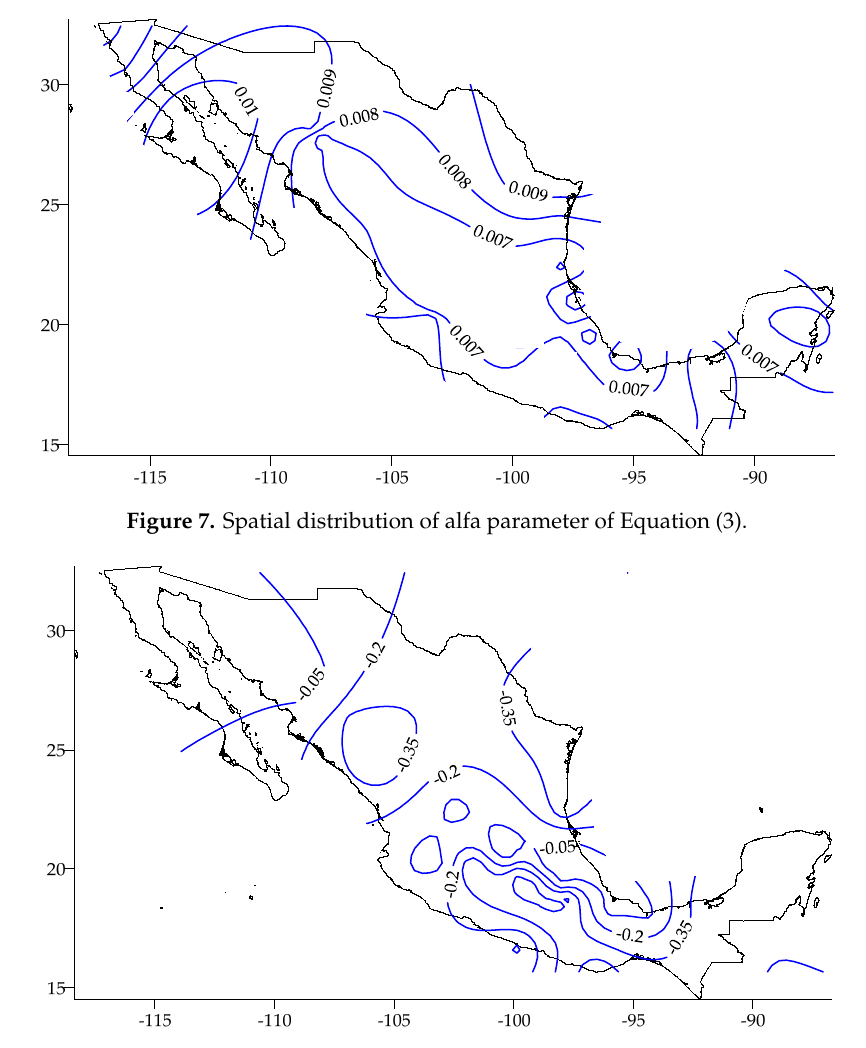
Figure 8. Spatial distribution of beta parameter of Equation (3).